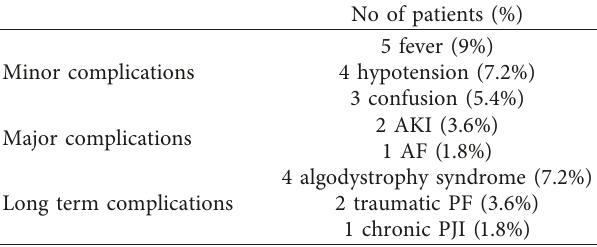
Table 4: Postoperative